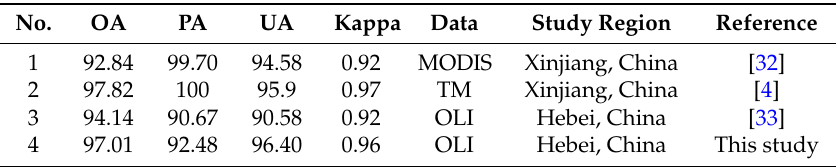
Table 13. Accuracies of the existing results. OLI: Operational Land Imager; MODIS: Moderate- resolution Imaging Spectrometer; TM: Thematic